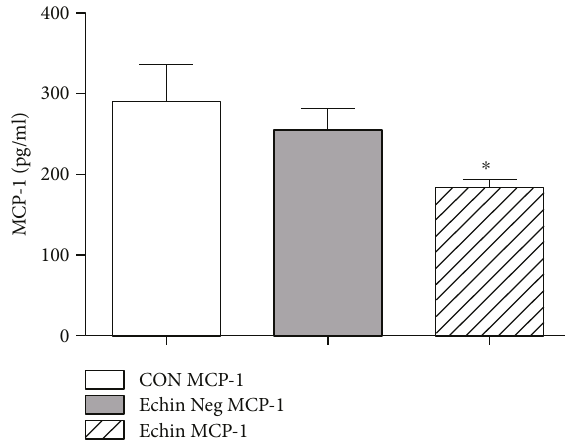
Figure 4: Serum levels in the group of infected patients (Echin MCP-1) are signi fi cantly decreased ( p < 0 05 ) versus the correspondent parameters in the group of Echinococcus -negative patients (Echin Neg MCP-1) and in the group of control subjects (CON MCP-1). ∗ p < 0 05 versus CON, after ANOVA and Fisher PLSD test.